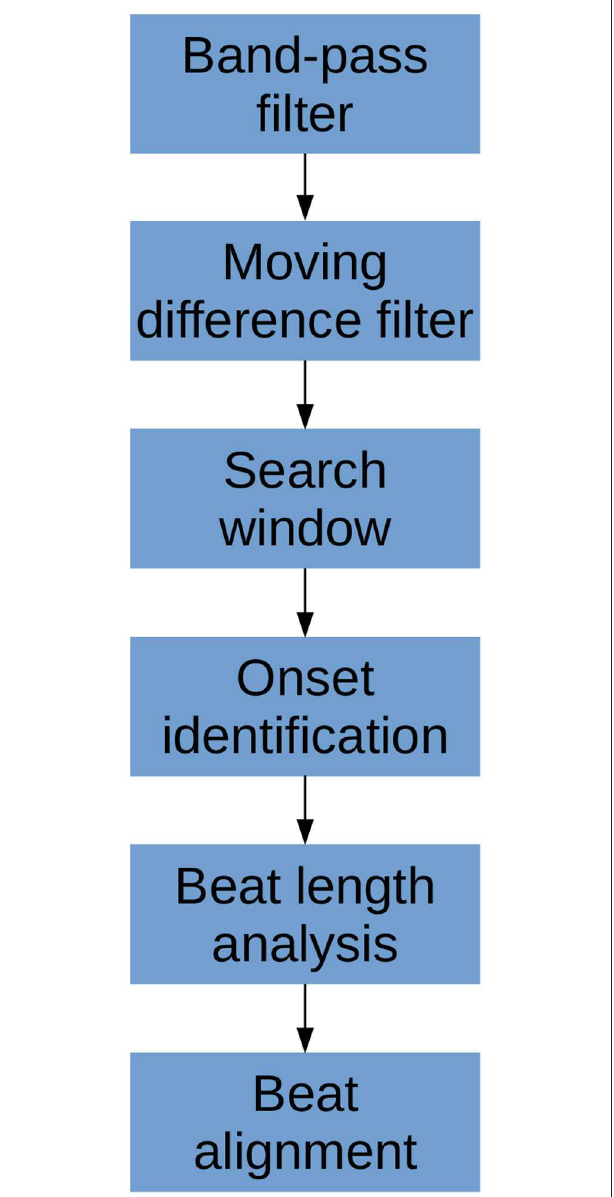
FIGURE 2 | The flowchart showing a high level overview of the steps involved in identifying beat onsets.